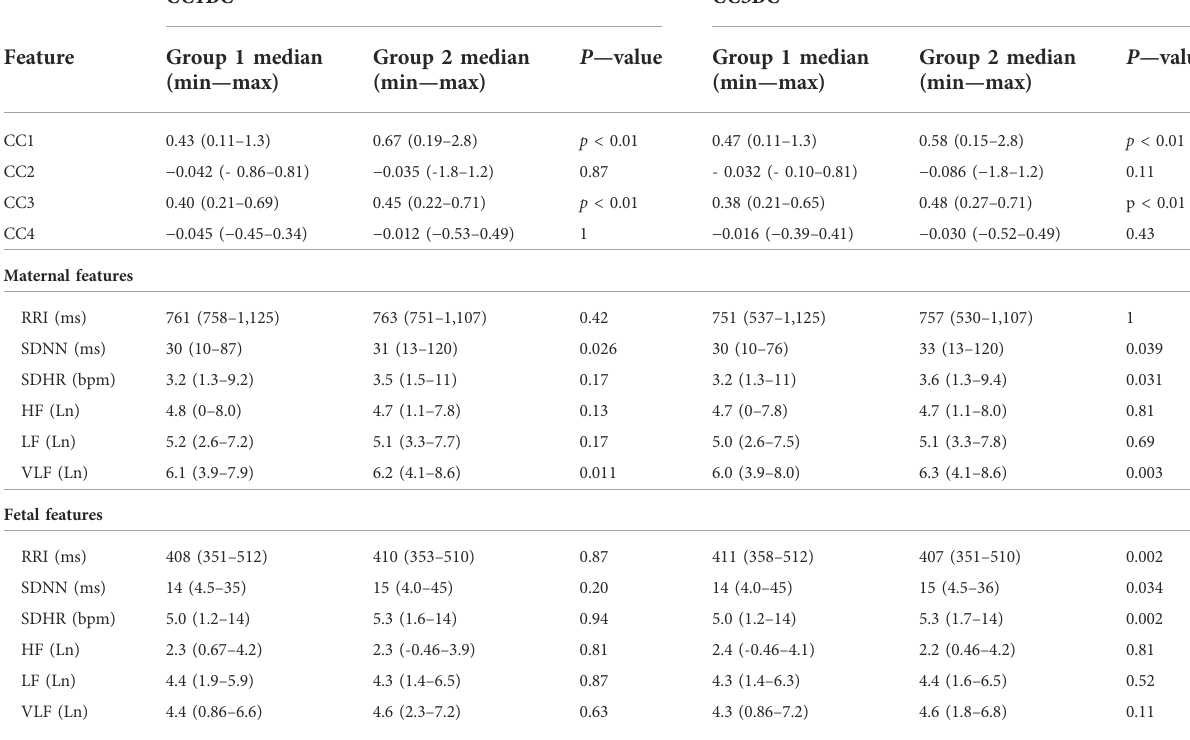
TABLE 3 Comparison in medians between Group 1 and Group 2 ( n =